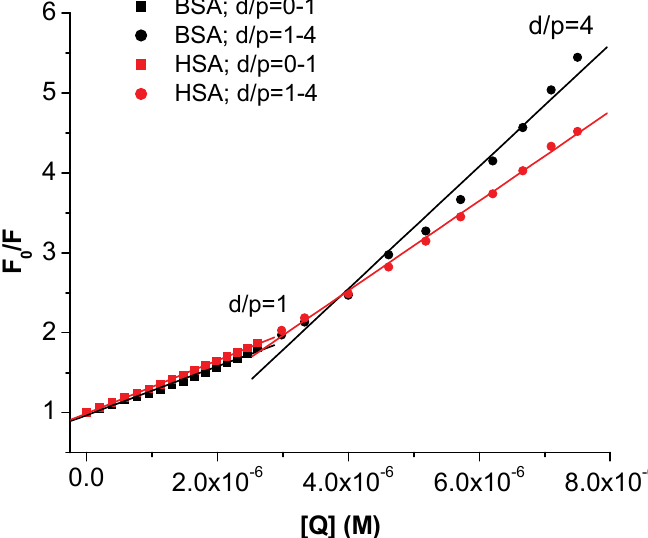
Figure 3. Two linear segments in Stern-Volmer plots for the quenching of HSA/BSA